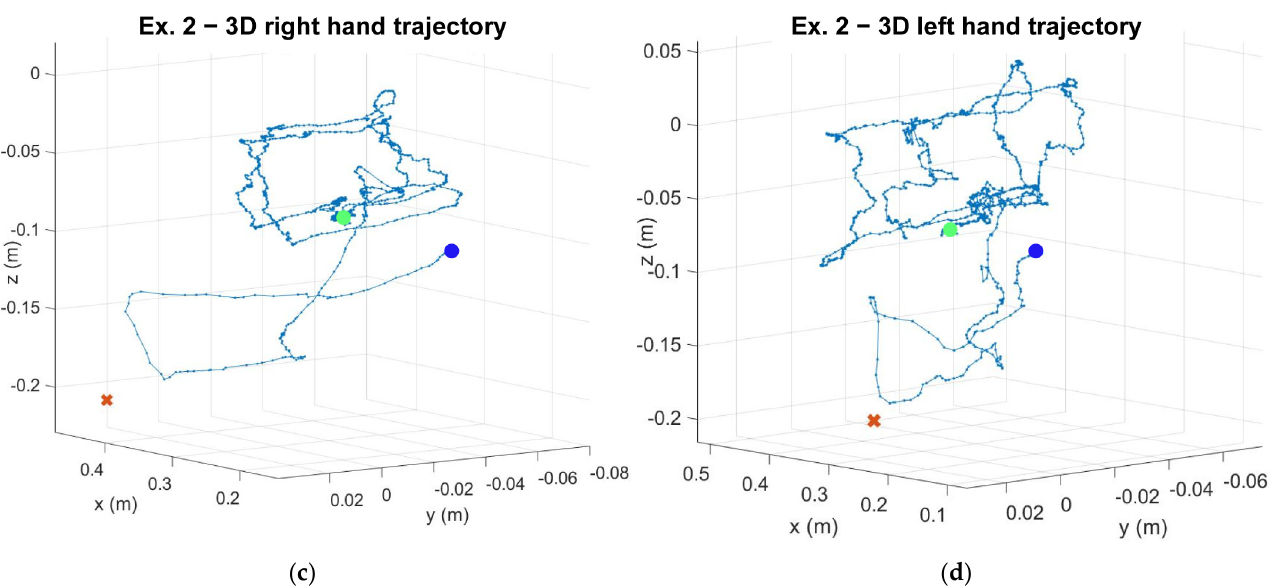
Figure 4. Graphs of the trajectories of the subject’s hand: ( a ) trajectory of the right hand during exergaming 1, ( b ) trajectory of the left hand during exergaming 1, ( c ) trajectory of the right hand during exergaming 2, ( d ) trajectory of the left hand during exergaming 2. The cross represents the position of the targets that are “grabbed” by the subject in the exergaming.